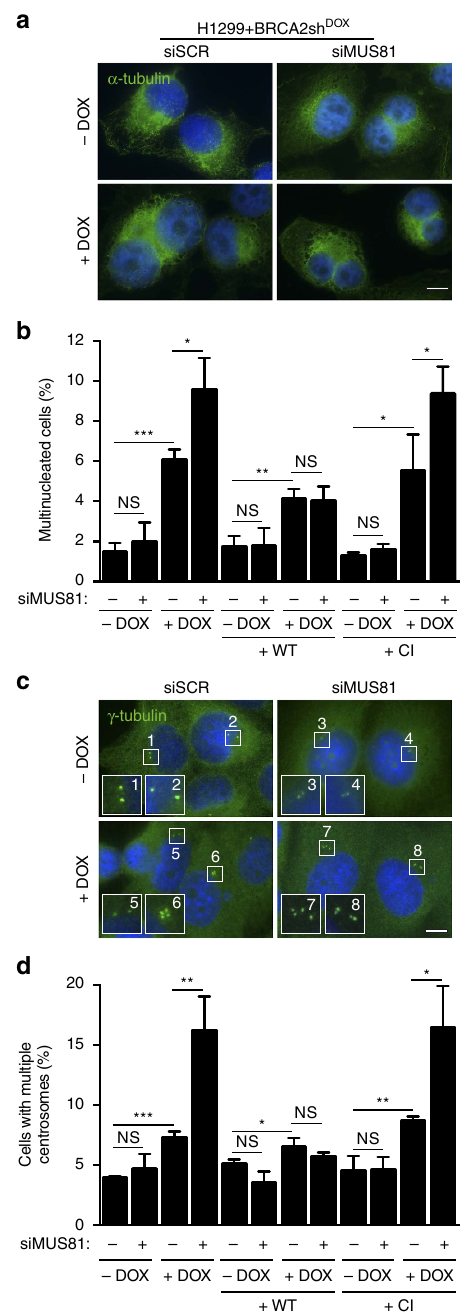
Figure 4 | MUS81 inhibition leads to multinucleation and supernumerary centrosomes in cells lacking BRCA2. ( a ) H1299 cells carrying a DOX- inducible BRCA2 shRNA were transfected with control or MUS81 siRNAs. Representative images of cells stained with an a -tubulin antibody (green) 72h after transfection are shown. DNA was counterstained with DAPI. Scale bar, 10 m m. ( b ) Quantification of the frequency of multinucleated cells in asynchronous cultures treated as in a . Similar analyses were conducted using stable cells lines expressing either WTor CI human MUS81. Error bars represent s.d. ( n ¼ 3). * P o 0.05; ** P o 0.01; *** P o 0.001 (unpaired two- tailed t -test). ( c ) Cells treated as in a were processed for immunostaining with g -tubulin (green) 72h after transfection. Insets show selected regions containing centrosomes at a higher magnification. Scale bar, 10 m m. ( d ) Quantification of the frequency of cells with multiple centrosomes treated as in c . Similar analyses were conducted using stable cells lines expressing either WTor CI human MUS81. Error bars represent s.d. ( n ¼